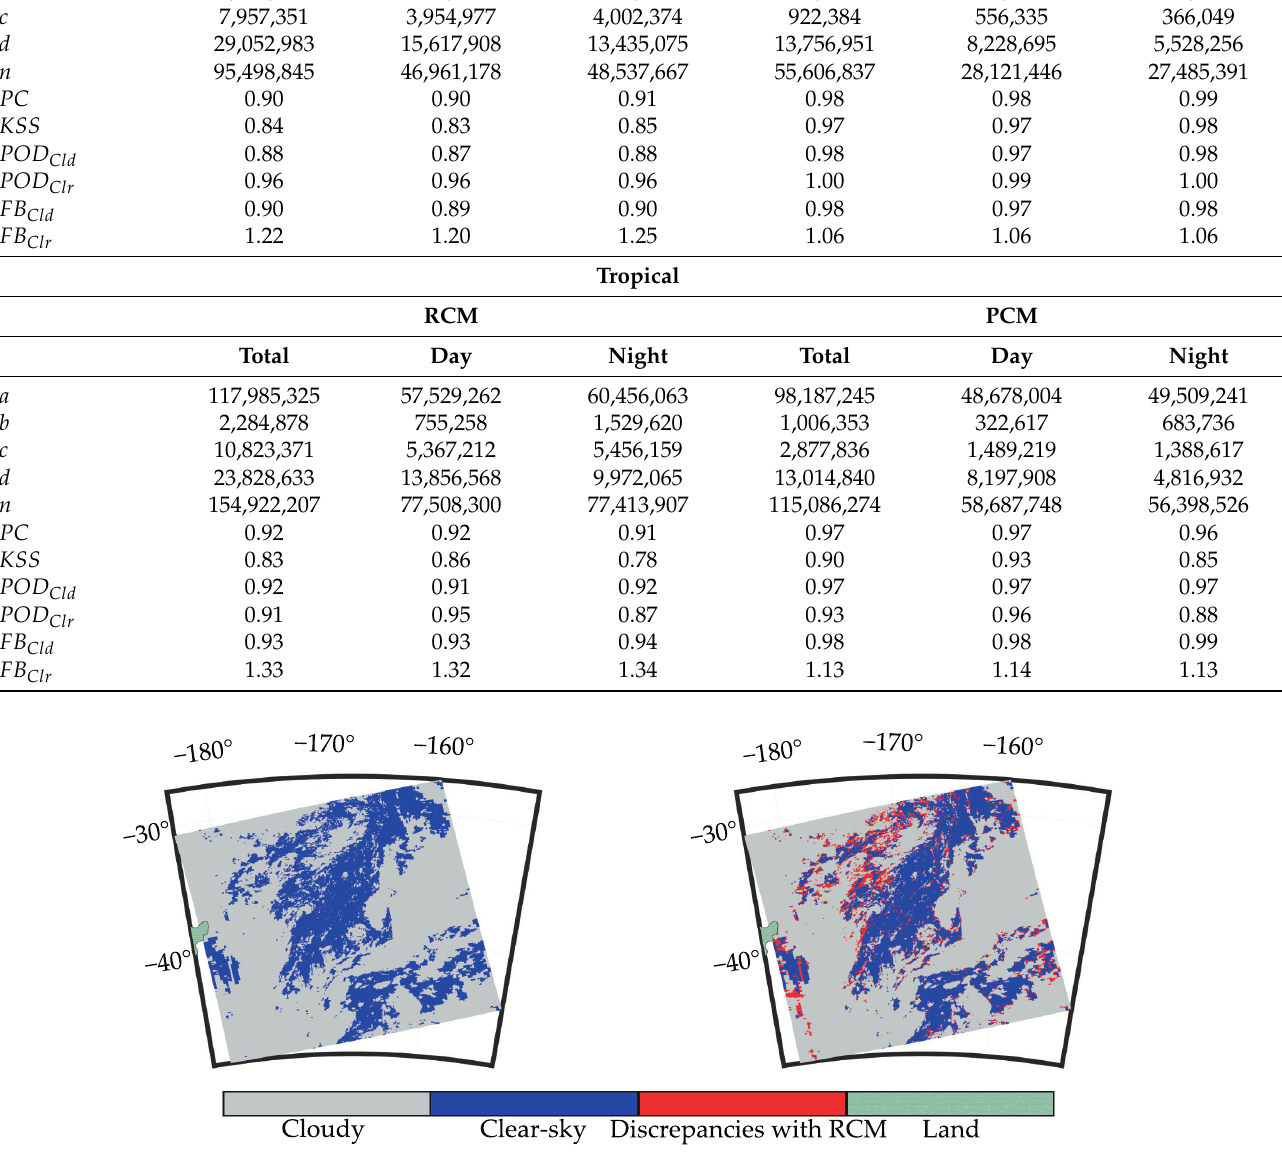
Figure 5. Selected case showing the performance of the mask comparing to MODIS CM. Left image shows the RCM. Right image shows the discrepancies between the SWCM and the